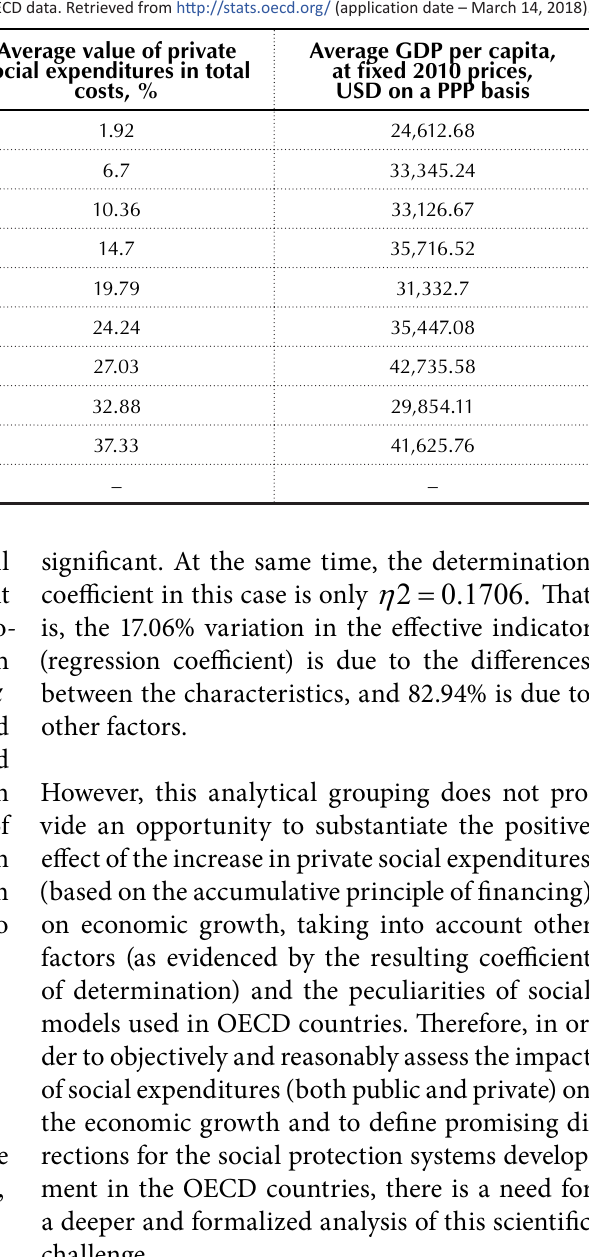
Table 3. Results of the OECD countries analytical grouping according to the correlation between the share of private social expenditures in the total costs and GDP per capita (average for the years from 1980 to